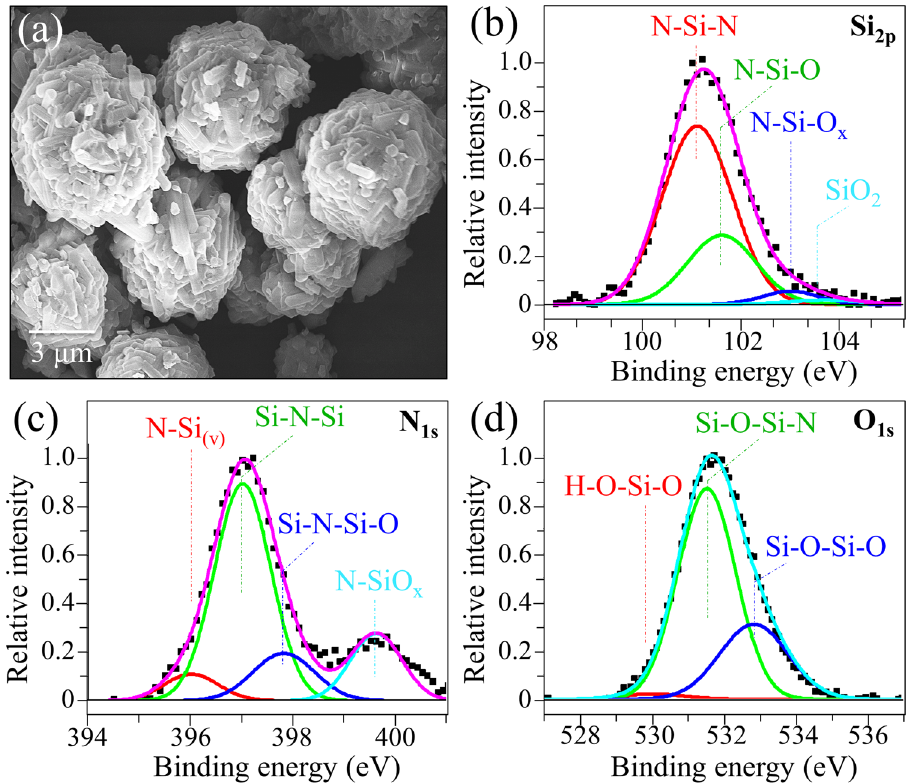
Figure 1. Characterizations of the as-received Si 3 N 4 powder: ( a ) scanning electron micrograph reveals size and morphology of the powder. In ( b )–( d ), XPS narrow scans at the Si 2p , N 1s , and O 1s edges with related deconvolution in sub-bands representing different bond populations at the surface of the material (cf.